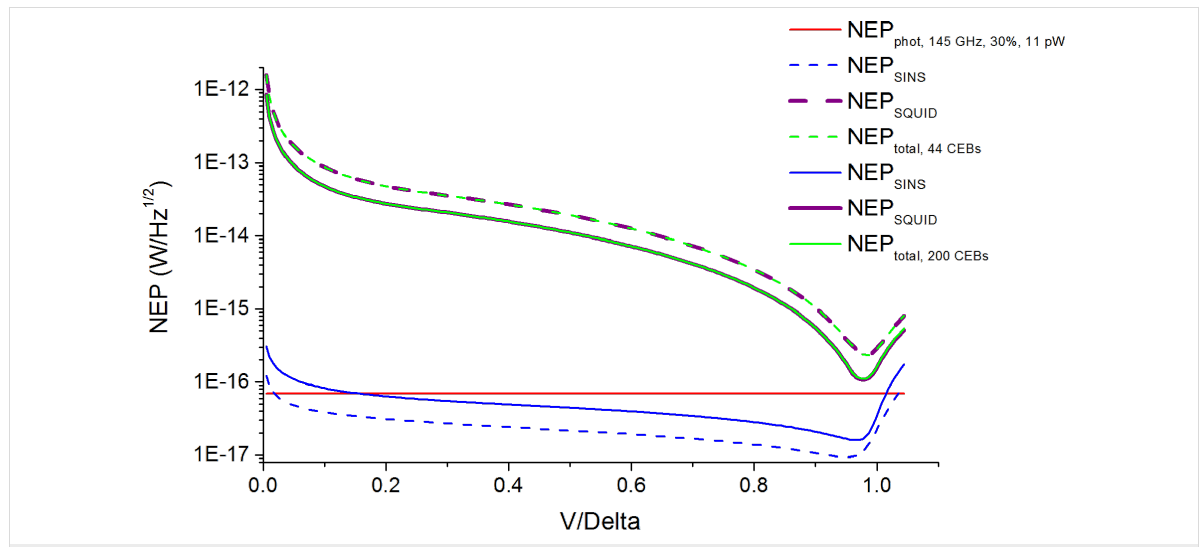
Figure 7: NEP estimations for the 145 GHz channel with 11 pW power load. Dashed curves are for 44 SINS CEBs; solid curves are for 200 SINS CEBs.